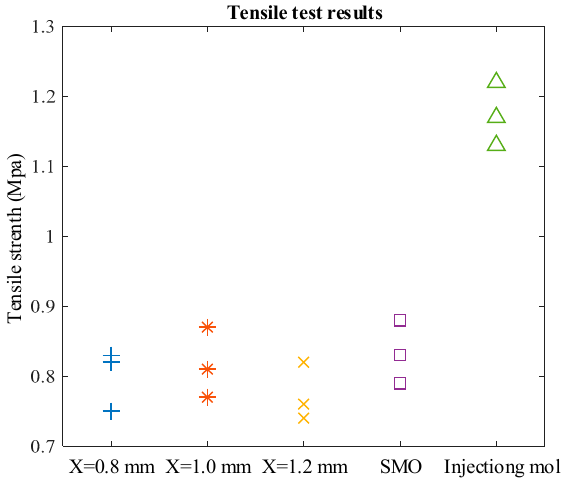
Figure 10. Results of tensile tests, where the blue plus sign shows the tensile strength of the specimen with a strand spacing of 0.8 mm, the red asterisk shows the tensile strength of the specimen with a strand spacing of 1.0 mm, the yellow cross shows the tensile strength of the specimen with a strand spacing of 1.2 mm, the purple square shows the tensile strength of the specimen made by the SMO method, and the green upward-pointing triangle shows the tensile strength of the specimen made by injection molding. Table 3. Printing efficiency of different filling